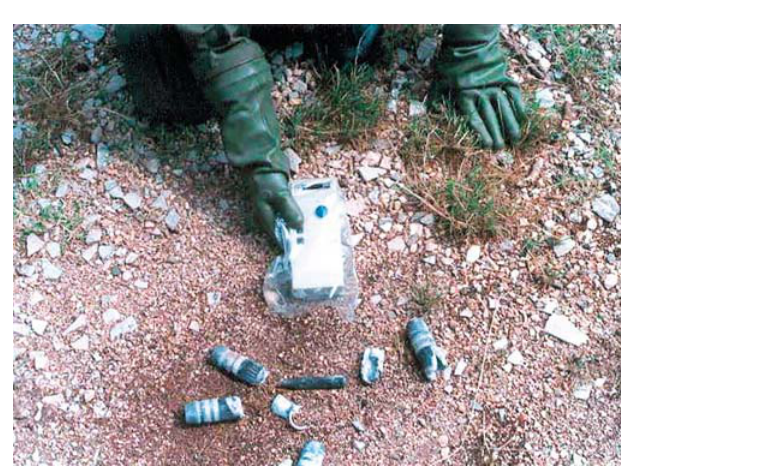
Figure 7 – Radiological reconnaissance of the place of DUA strike Рисунок 7 – Изображение радиологической разведки участки БОУ